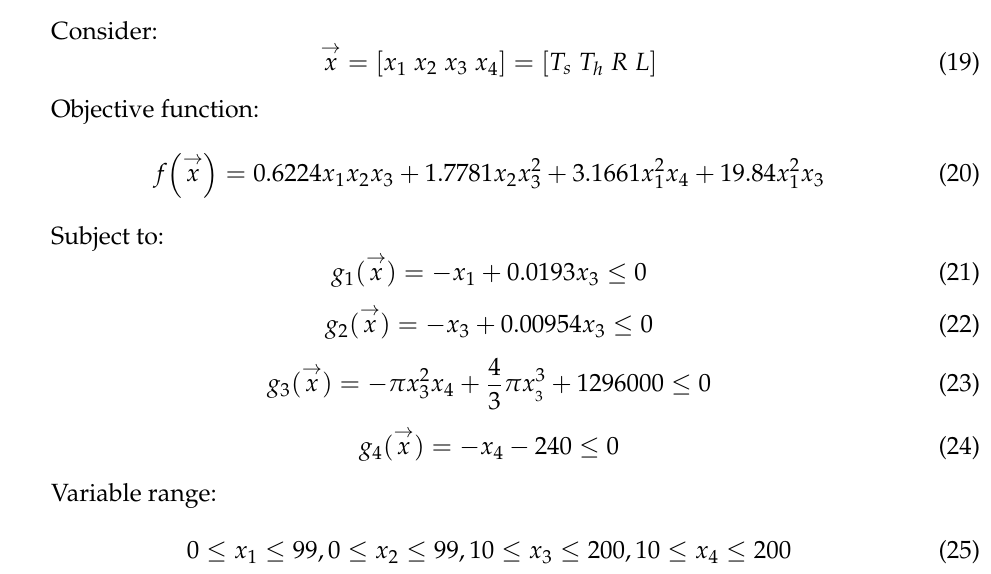
Table 8. Experimental results of pressure vessel design.